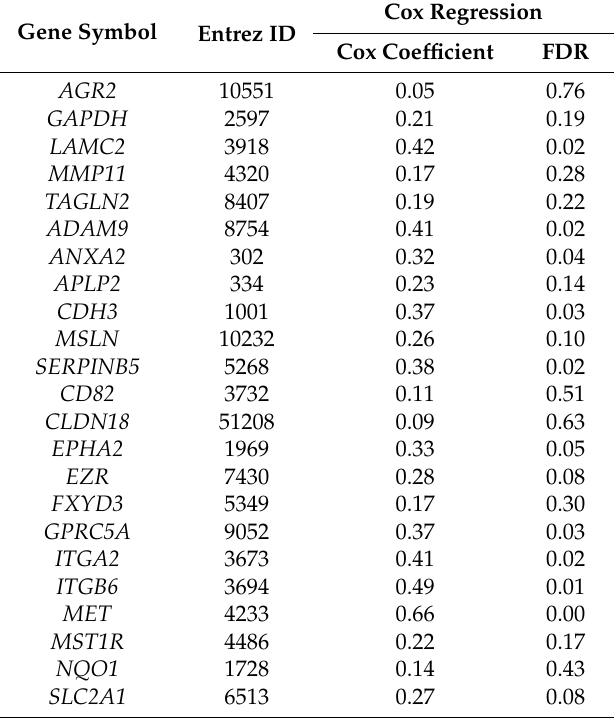
Table 2. Combined effect sizes, Cox regression analysis, and alterations at the mRNA and protein level of the 23